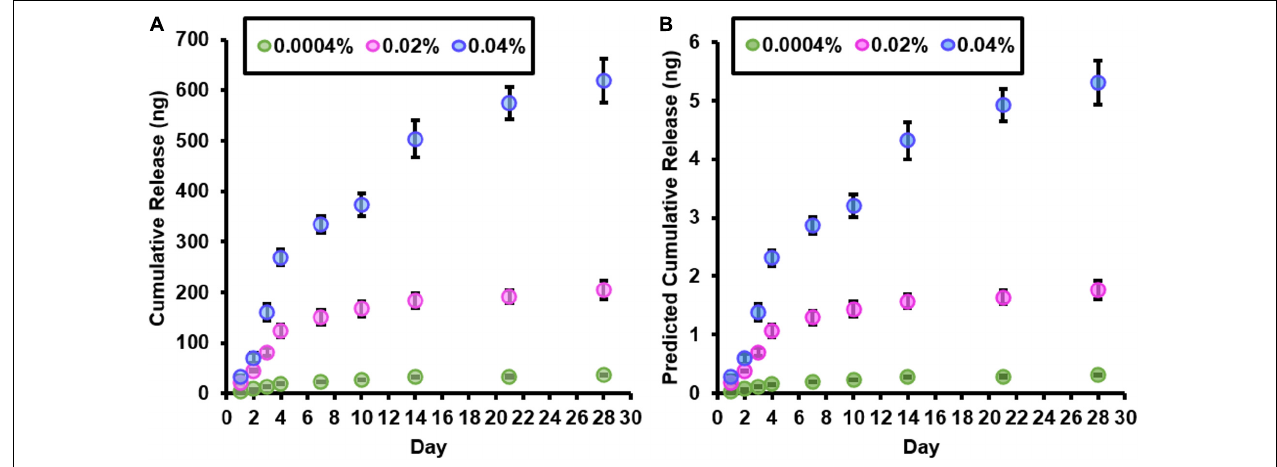
FIGURE 3 | Fingolimod-loaded fibers continuously release fingolimod for at least 28 days. (A) Cumulative release (in ng) of fingolimod from 350 mg of 0.0004% (green), 0.02% (pink), and 0.04% (blue) fingolimod-loaded electrospun fibers over 28 days. (B) Predicted cumulative release of fingolimod (in ng) from a single 0.0004% (green), 0.02% (pink), and 0.04% (blue) fingolimod-loaded electrospun fiber scaffold over 28 days. An individual fingolimod-loaded electrospun fiber scaffold contains 3 mg of fibers. Data are represented by the mean mass of drug released (in ng) ± standard